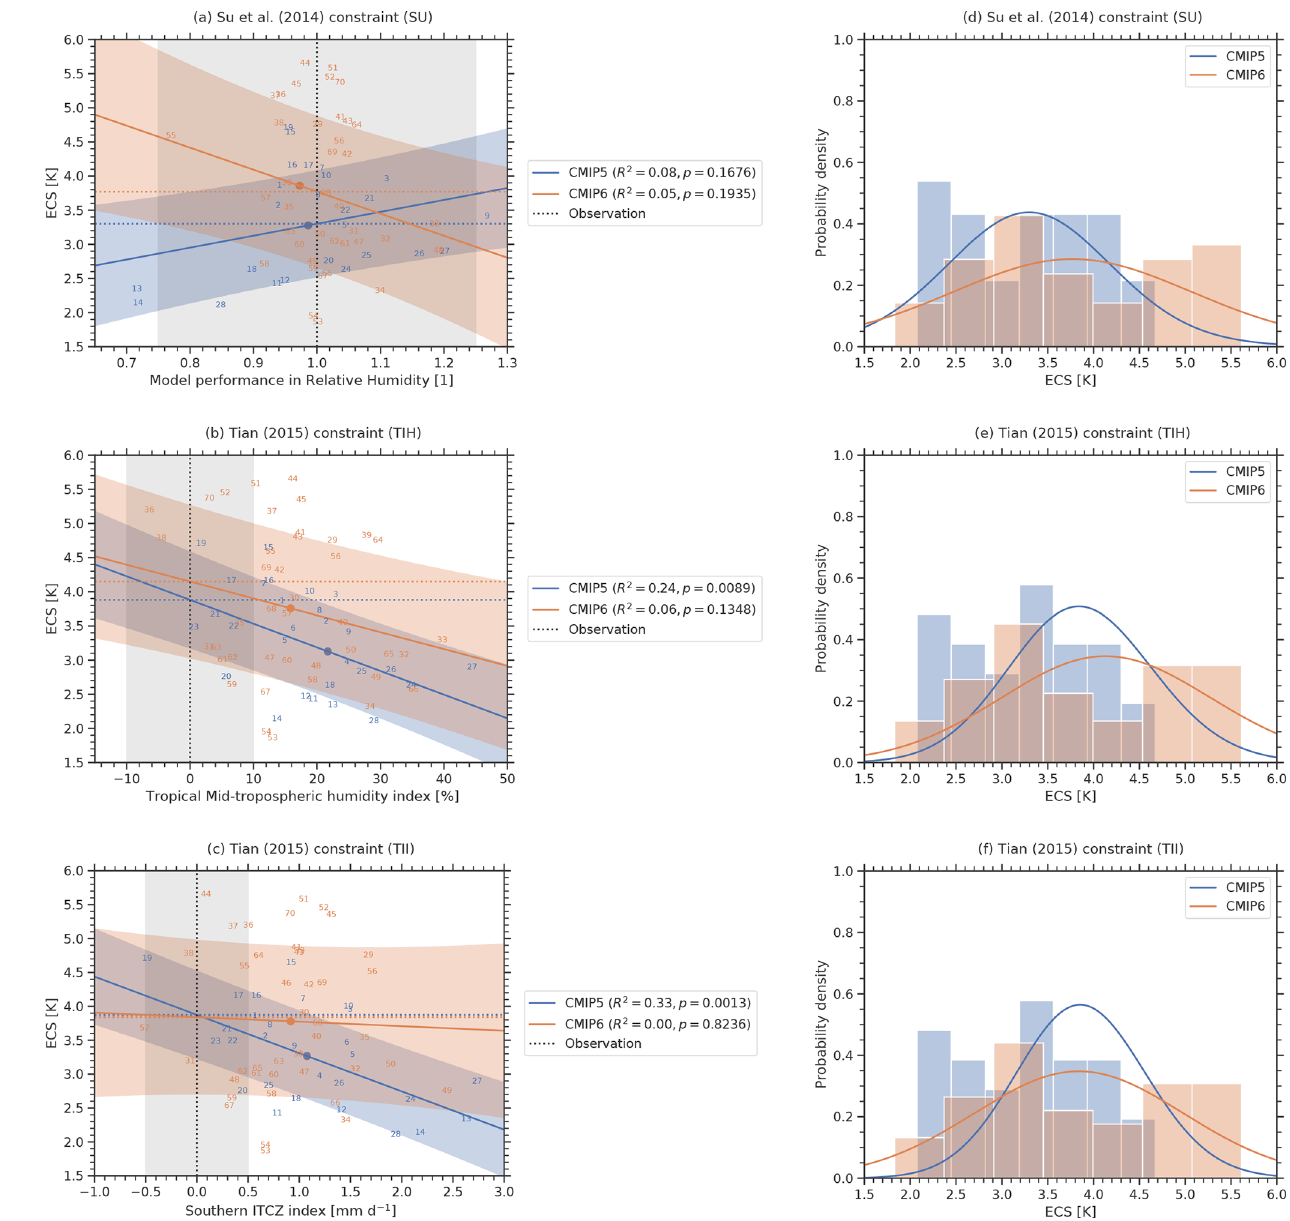
Figure 4. As in Fig. 2 but for the constraints SU, TIH, and TII.